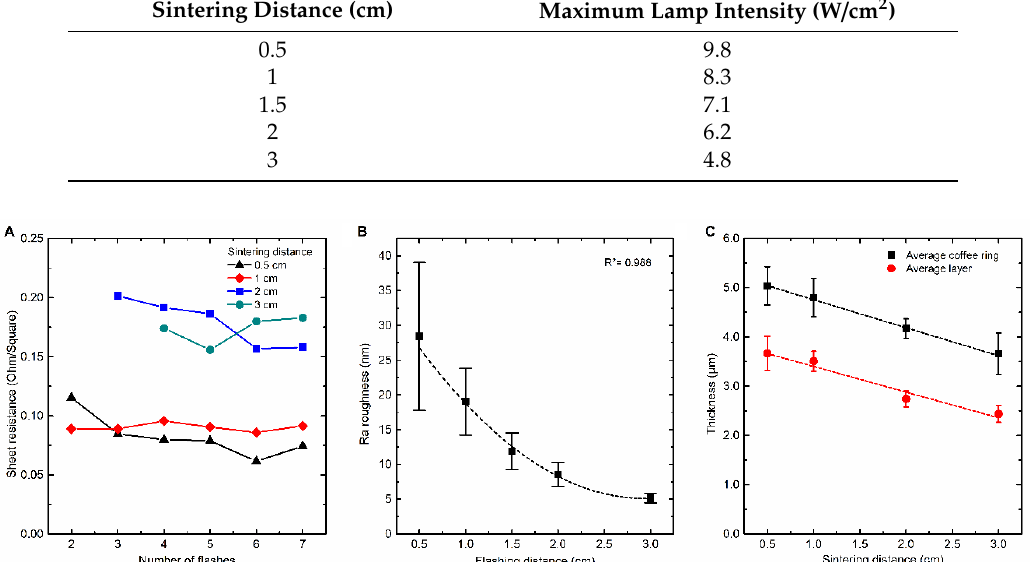
Table 2. Overview of the appearance of a coffee ring during different ink and sintering configurations. Table 1. The theoretical maximum sintering intensity has an exponential decrease when increasing the Using the appropriate sintering technique according to the ink type leads to a significant lower coffee ring effect (130–150% instead of 240–350% of the average layer thickness). lamp to sample distance. Based on a radiation angle of 120 ◦ and 100% lamp e ffi ciency (@400W).